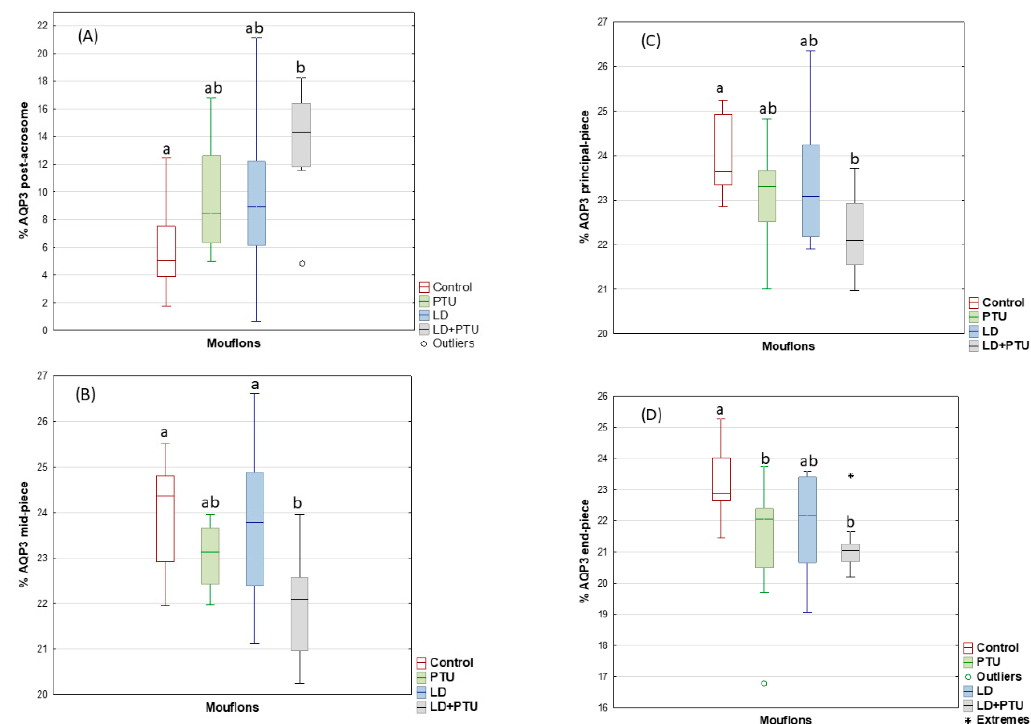
Figure 8. AQP 3 expression by immunocytochemistry labelling (ICC) in post-acrosome ( A ), mid- piece ( B ), principal piece ( C ) and end-piece ( D ) of mouflon sperm (controls (red); administered propylthiouracil (PTU, green), exposed to long day photoperiod (LD, blue), exposed to long day photoperiod plus PTU (LD+PTU, gray)). The boxes spread form the 1st to the 3rd quartiles. Box plots show the median (horizontal line) and spread from the 1st to the 3rd quartiles; the whiskers extend from the smallest to the largest value. Outliers are shown as circles and extremes as asterisks. Different letters (a,b) between boxplots indicate significant differences ( p < 0.05).